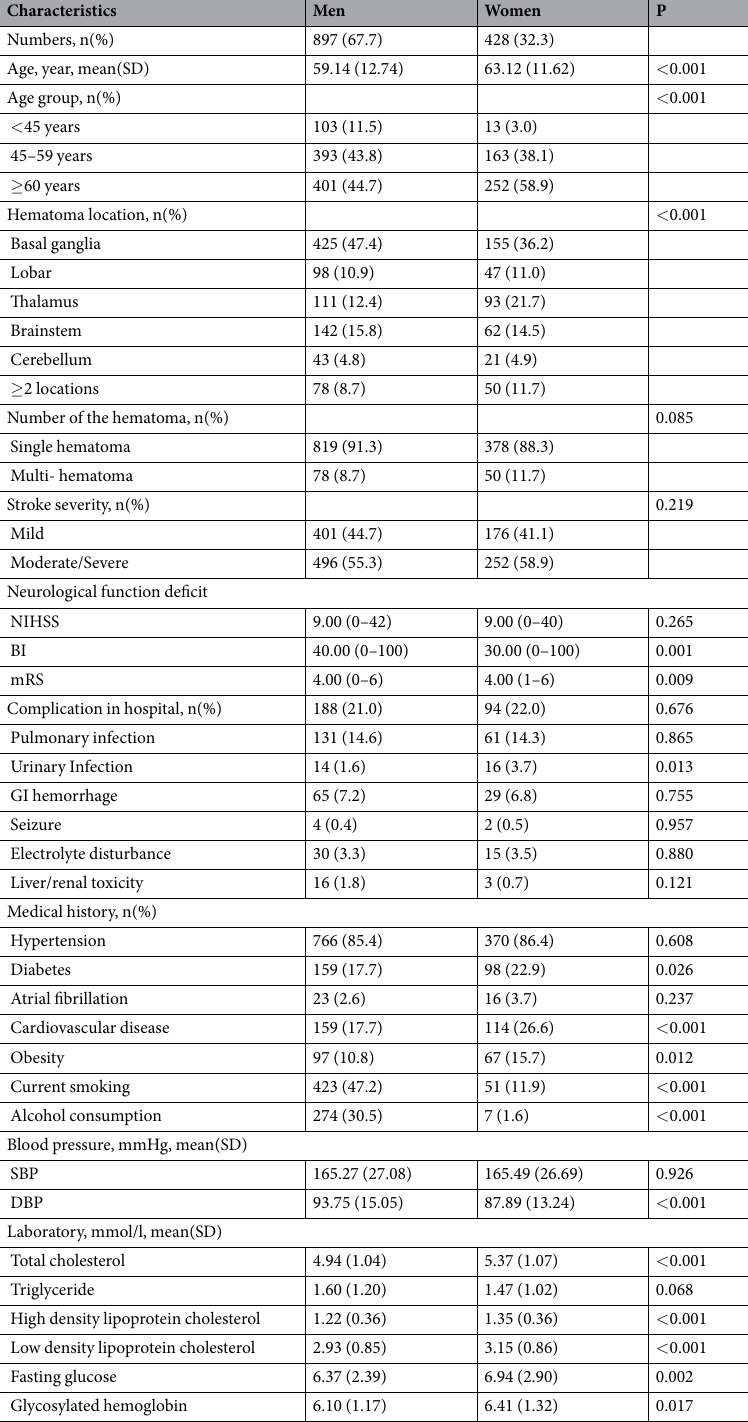
Table 1. Sex differences in demographical and clinical